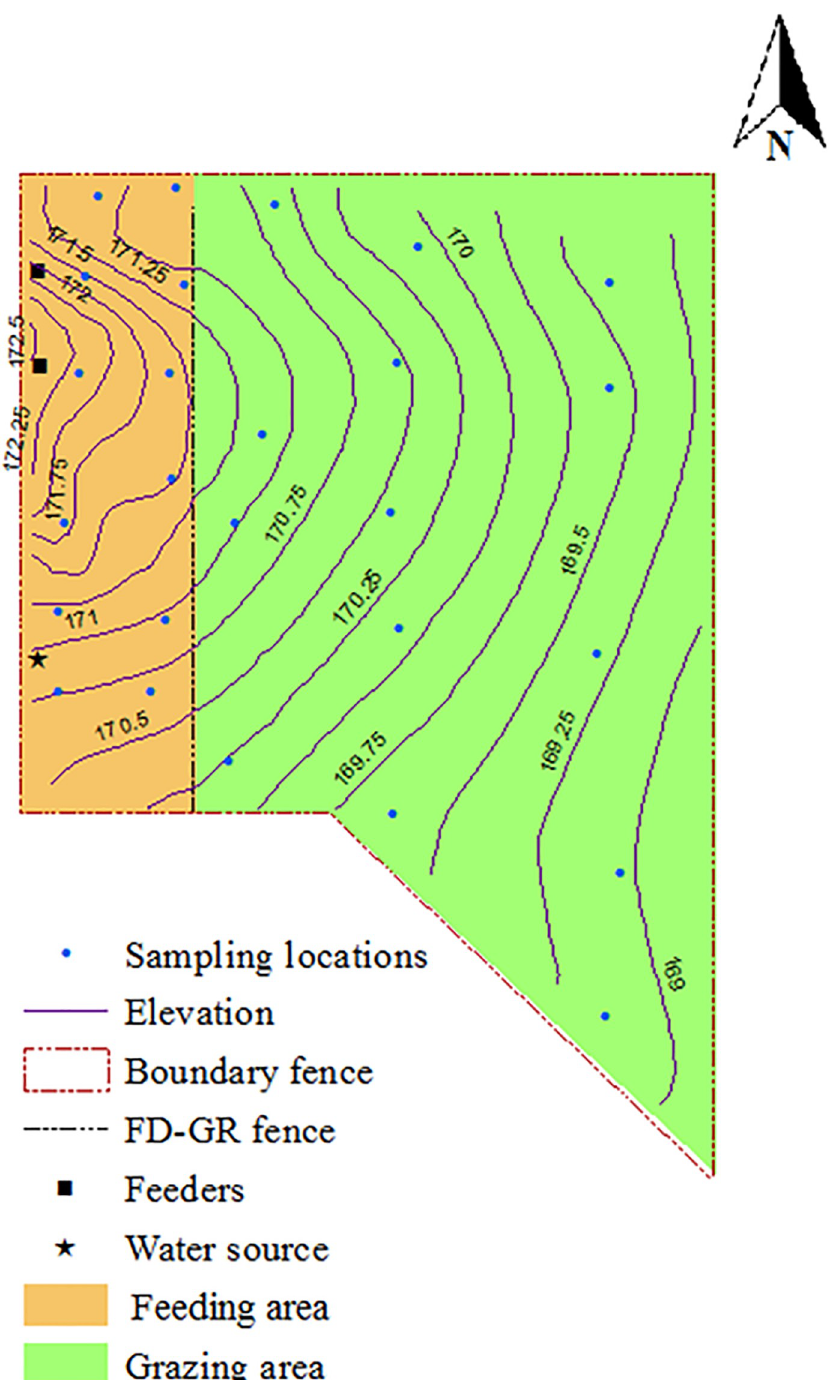
Fig 1. Georeferenced soil sampling locations at beef cattle backgrounding environment monitored for the persistence of antibiotic resistance genes for two years after cessation of operation. The facility was divided into feeding (FD) and grazing (GR) areas separated by a